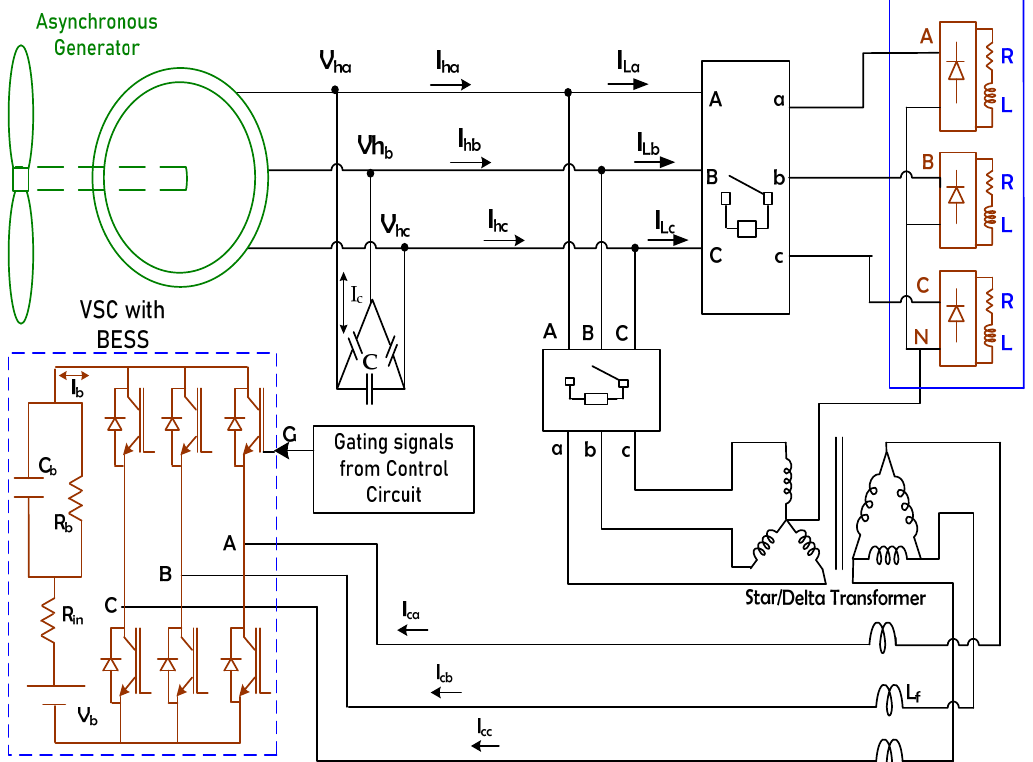
Figure 2. Schematic diagram of the Wind Power Harnessing Unit under study. V ha , V hb and V hc : Source voltages (harnessed voltages); I ha , I hb , and I hc : Source currents in phase a, phase b and phase c respectively; I La , I Lb , I Lc : Load currents in phase a, phase b and phase c respectively; I ca , I cb , I cc : Compensating currents, I c : Current through the excitation capacitor, I b : Battery current; V b : Battery voltage, R in : Internal resistance of the battery, C b : Battery Capacitance, R b : Resistance of the capacitor, L f : Filtering inductor.